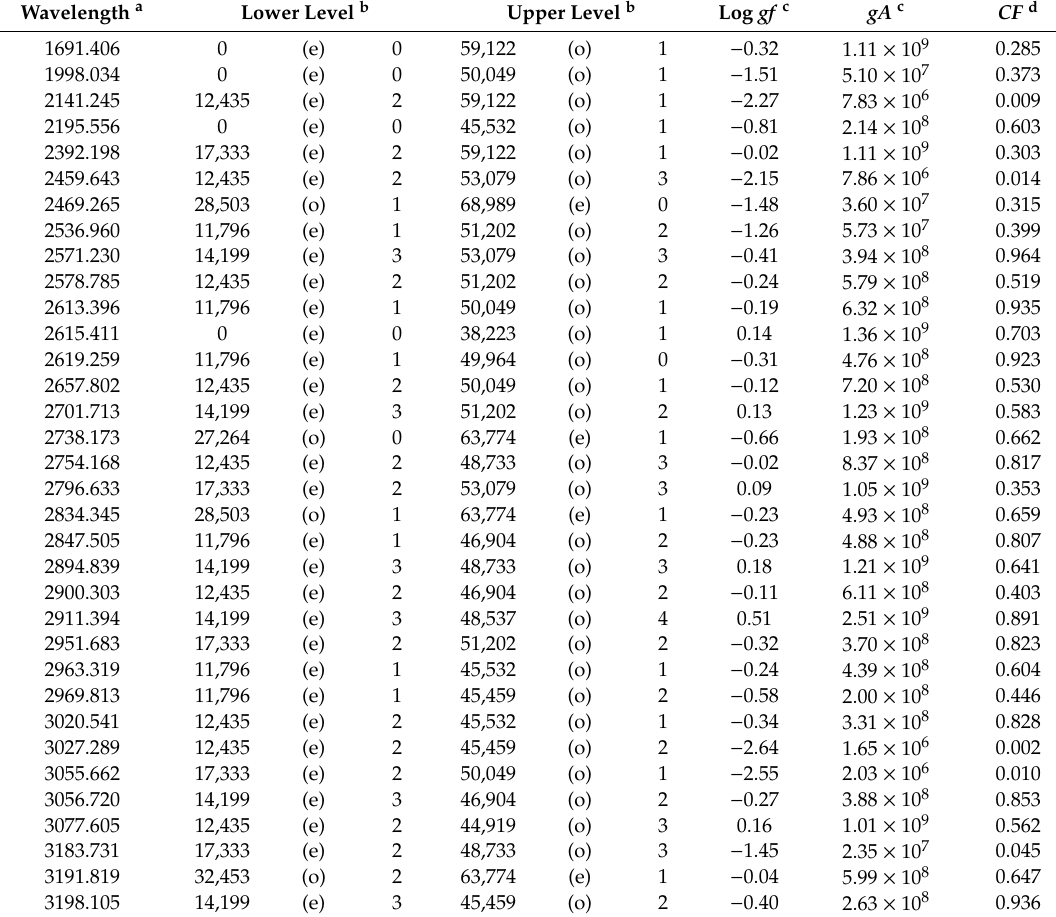
Table 4. Sample of data listed in the DREAM database for Lu II